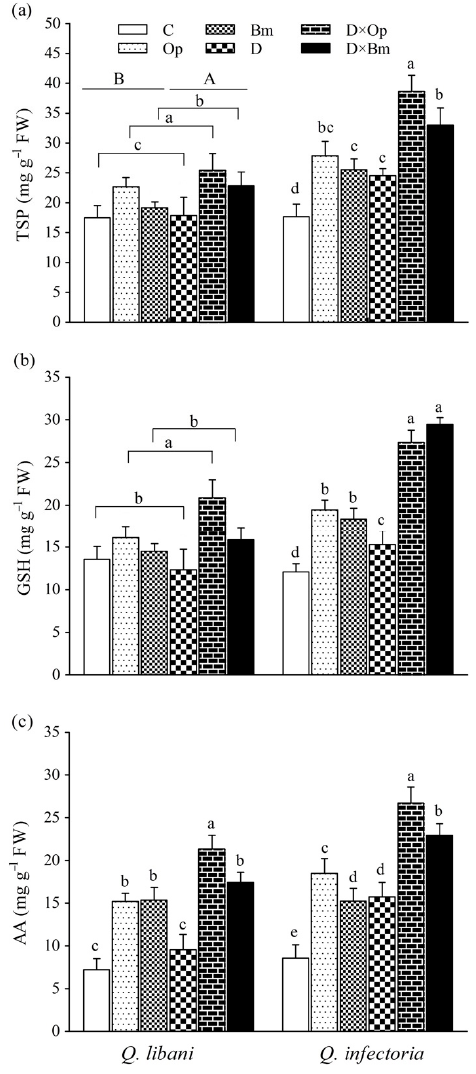
Figure 8. ( a ) Total soluble protein (TSP), ( b ) glutathione (GSH), and ( c ) ascorbic acid (AA) contents in leaves of Quercus libani and Q. infectoria seedlings affected by charcoal disease and drought (Op: Obolarina persica , Bm: Biscogniauxia mediterranea , D: Drought, D × Op: Drought × O. persica and D × Bm: Drought × B. mediterranea ). Bars represent means + standard error, n = 3. Different lower- case letters indicate statistically significant differences between the treatments at α = 0.05 based on Tukey’s multiple comparison